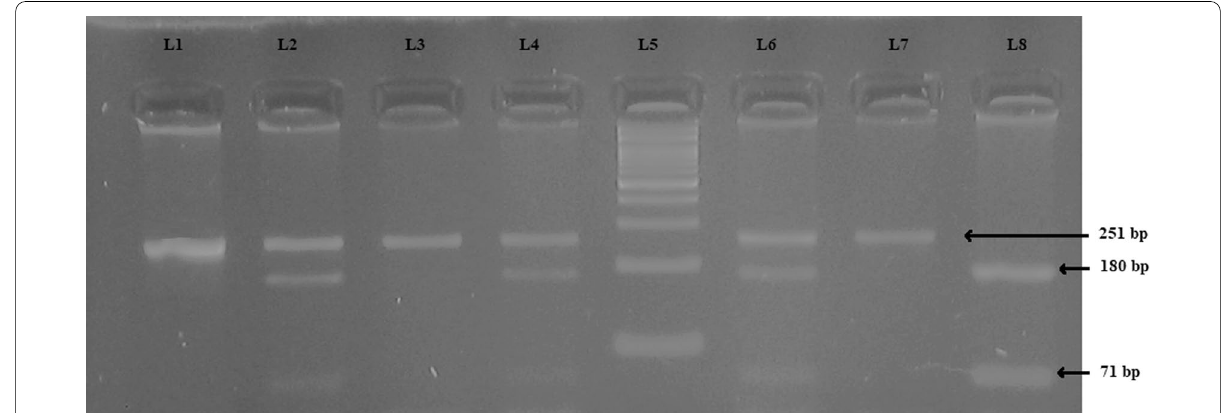
Fig. 2 The 4% agarose gel picture of BbsI digested products of TNF-α rs1799964gene. Lane 1 shows undigested PCR product corresponding to a band of 264 bp; lanes 2, 4 and 6 show CT genotype corresponding to three bands size of 251 bp, 180 bp and 71 bp; lanes 3 and 7 show the CC genotype corresponding to one bands of 251 bp, whereas lane 8 shows TT genotype corresponding to two band of 180 bp and 71 bp and lane 5 shows 100 bp